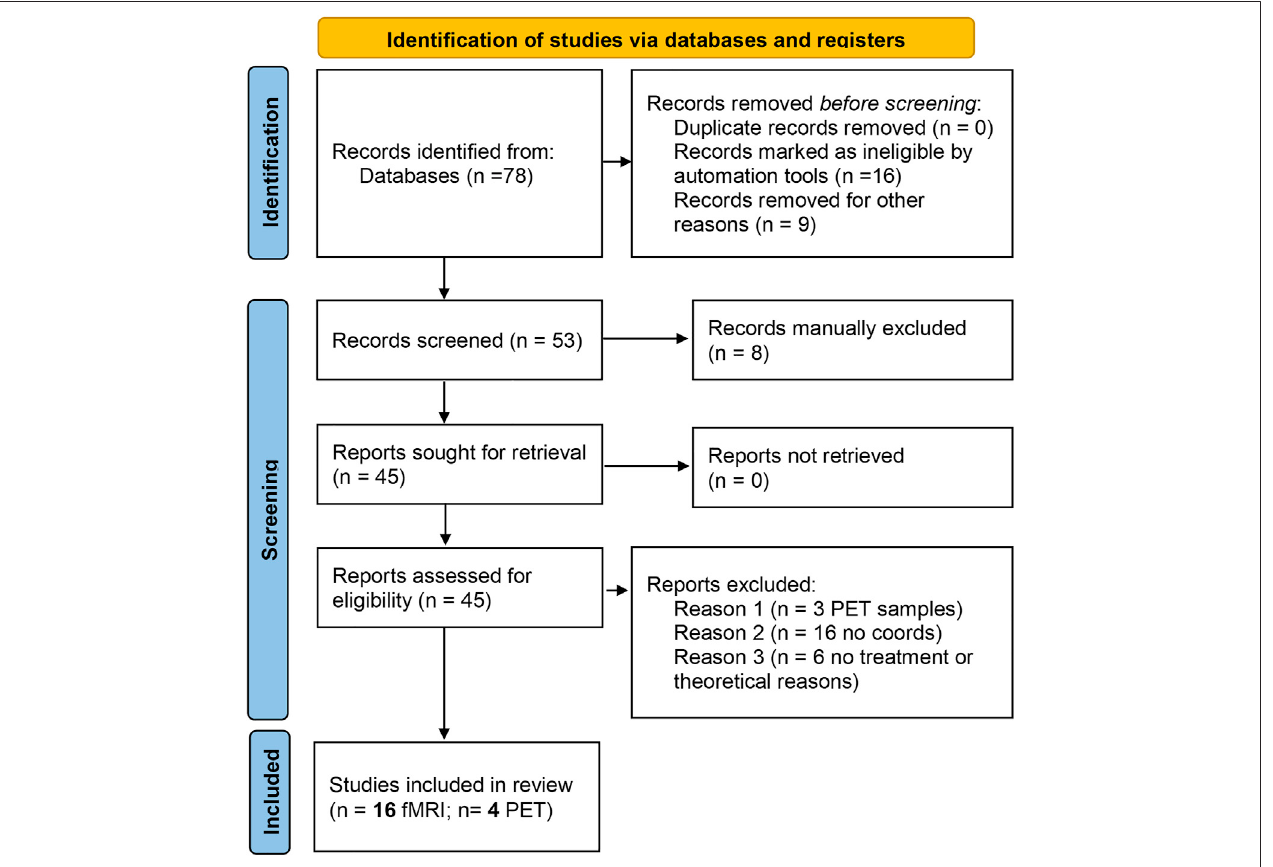
FIGURE1 | PRISMA fl ow diagram for the meta-analysis. The summary ofpapers identi fi ed through databases search, screened for theinclusion/exclusion criteria and included in the fi nal analysis are reported in the standard PRISMA diagram.